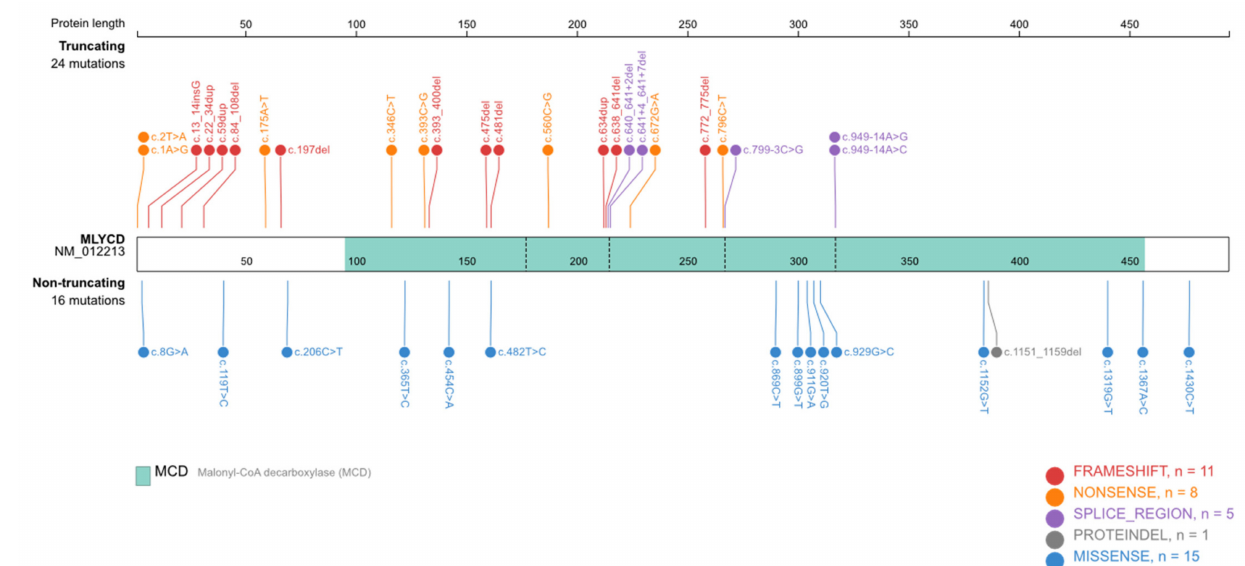
Figure 4. Molecular variations described in the literature represented along the MLYCD protein. Limits between the five exons are represented by the dotted lines. In blue, the decarboxylase protein domain. Twenty-four variations are truncating variants, including nonsense, frameshift indels, and splicing variants, and 16 are missense variants or deletion without frameshift. Nonsense variants include the two losses of start codon variants. The full list is presented in Supplementary Table S2. Large deletions are not reported on this figure. The figure was generated using https://proteinpaint.stjude.org/ (accessed on 15 October